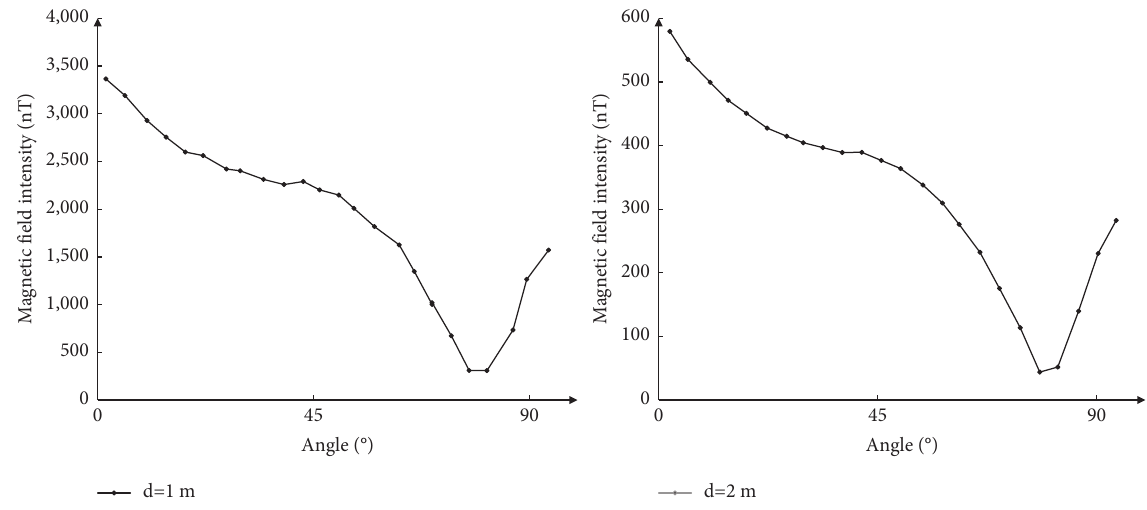
Figure 14: Effect of the angle between drilling well and adjacent well on measurement